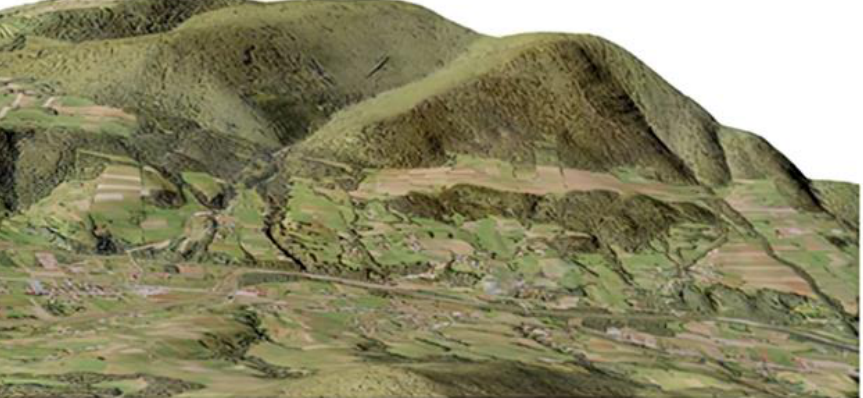
Figure 25. Area of elaboration — DTM model with superimposed texture, bird ’ s eye view.